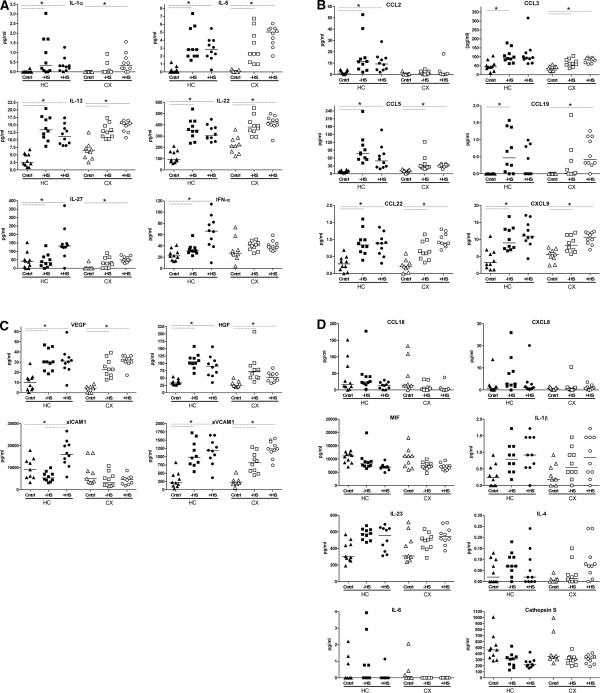
HC and CX expression patterns of other inflammatory proteins. Interleukins (A), chemokines (B), miscellaneous inflammatory proteins (C), and inflammatory proteins with p-values 0.0017-0.05 which were not tested post-hoc (D). Scatterplots of individual protein levels per patient group. Horizontal lines represent the median expression level of the group